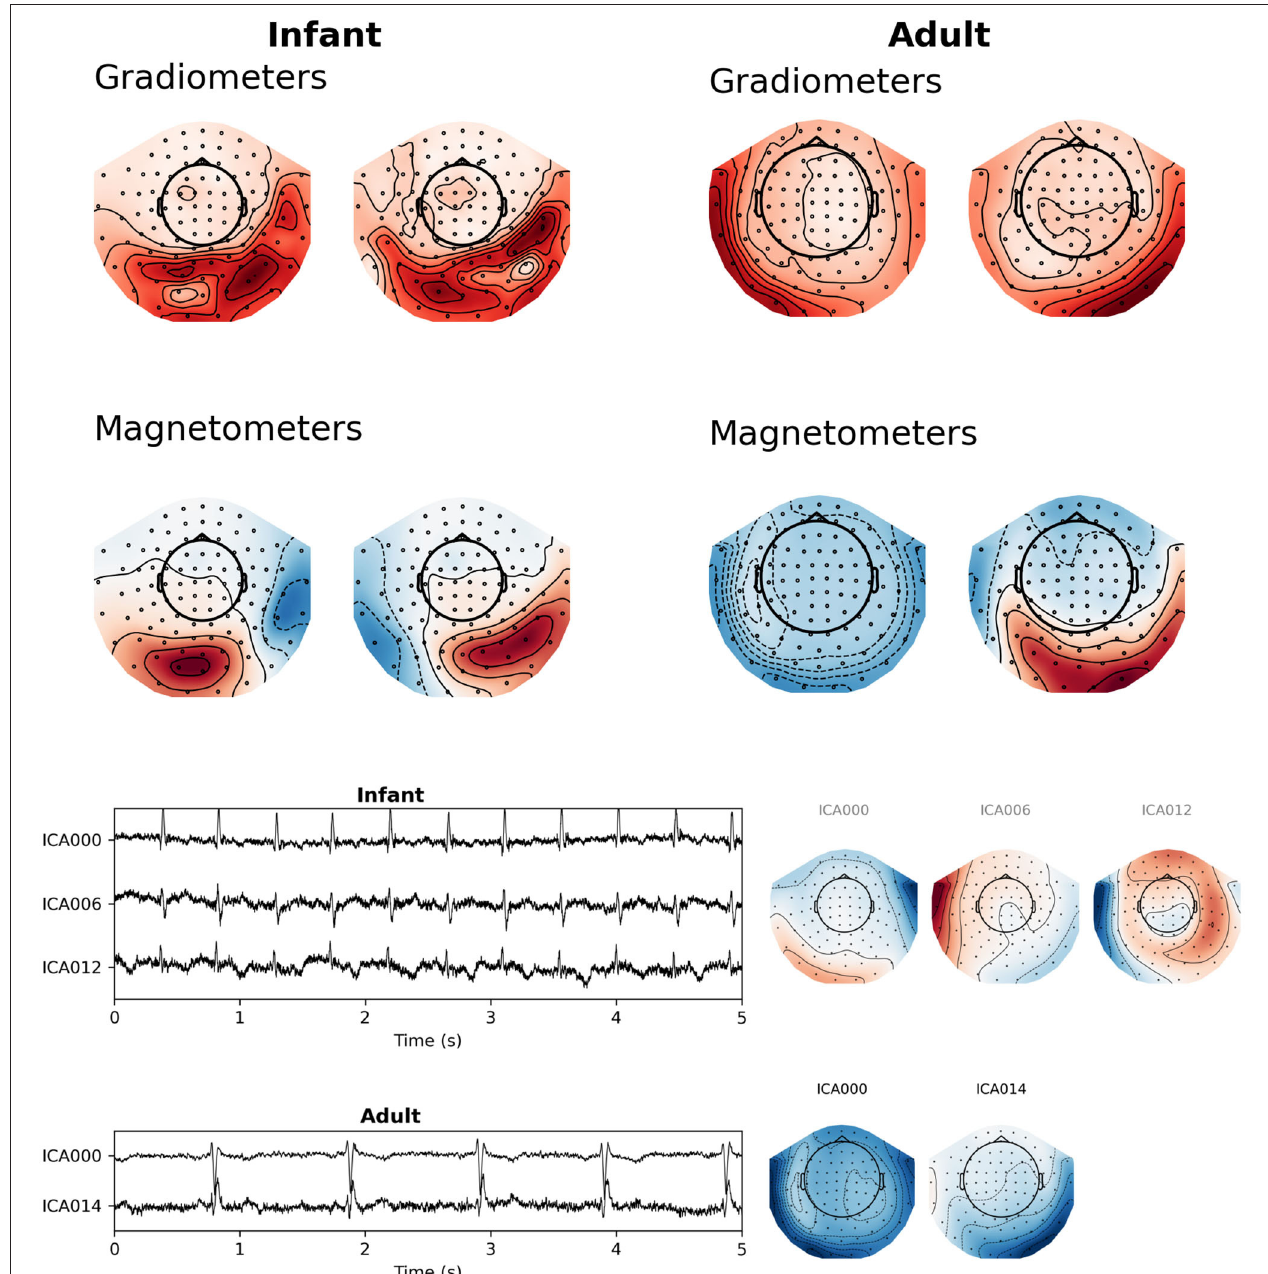
FIGURE 5 | Topographic maps of cardiac fields for sample infant and adult MEG recordings. (Top) SSP projector fields computed from a 100ms window surrounding the average QRS peak from this figure was sufficient to capture the artifact. (Bottom) latent sources and field maps for cardiac-related latent components computed with ICA. Both approaches show that fields from heart-generated volume currents in the brain may appear shallow or asymmetrical compared to adult cardiac fields.